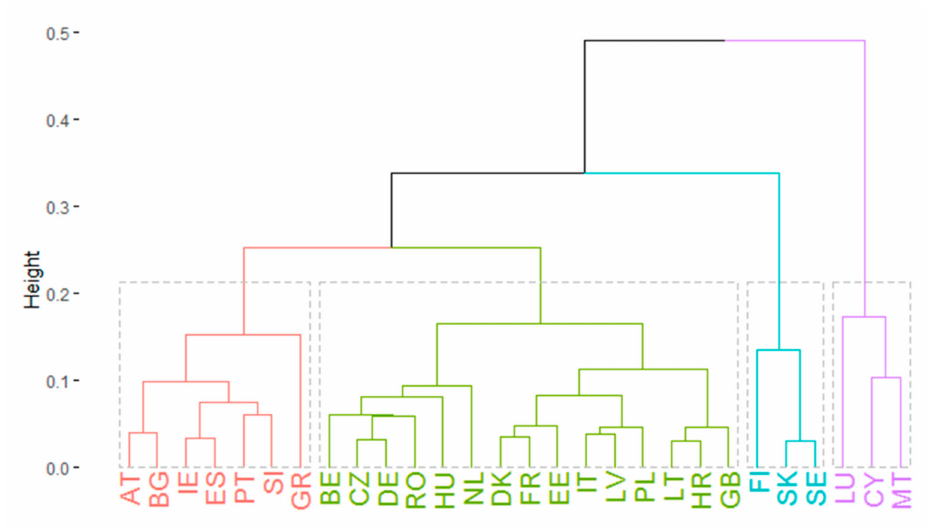
Figure 16. The dendrogram of DIANA clustering for countries from EU. Countries tagged using ISO Alpha-2